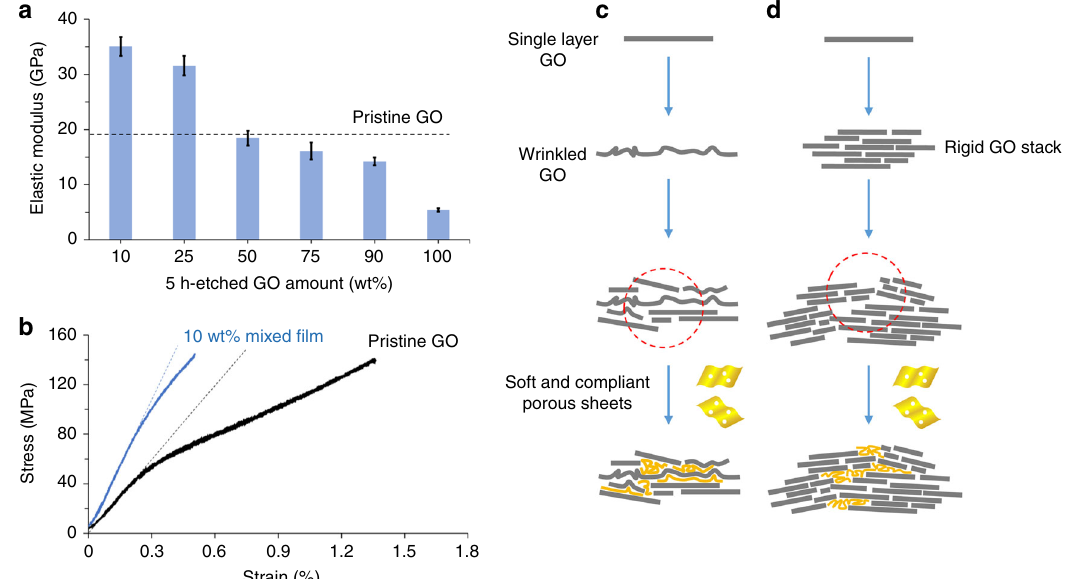
Fig. 4 Stiffening of GO fi lms by soft porous sheets. a Elastic moduli of mixed multilayer fi lms with various fractions of 5-h-etched GO. Error bars represent SD. b Representative stress – strain curves of a pristine GO fi lm and another with 10 wt% of 5-h-etched GO. Dashed lines represent the calculated elastic moduli of the fi lms. These results revealed an intrinsic dilemma for pristine GO sheets that prevents them from continuously conformal stacking. c First, GO sheets are easily wrinkled or folded during processing, which disrupts the packing of neighboring sheets. d Second, even if wrinkle-free sheets tightly stack, they form platelets that are drastically more rigid, and less compliant, preventing for further conformal packing. Both c and d result in architectural defects (red circles) in the multilayer fi lms, which would become stress concentrators to degrade the overall mechanical properties. Thus, the much softer porous GO sheets effectively serve as a binder, allowing more compliant packing in the multilayer fi lms, leading to higher